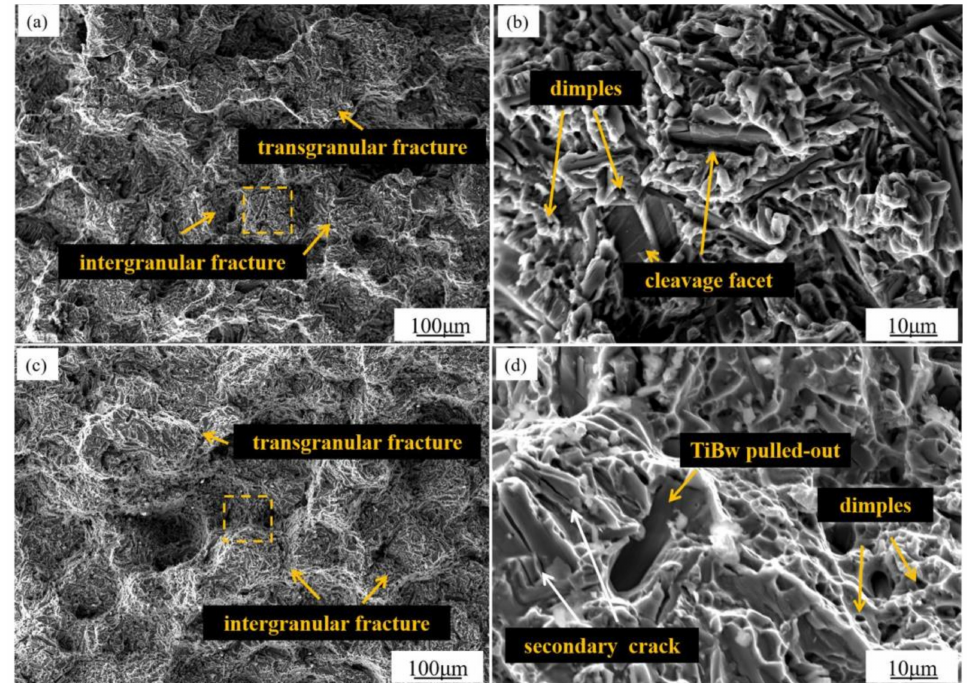
Figure 3. Fracture surface of TiB w /Ti-6Al-4V brazing joints brazed in 940 ◦ C for 2 h ( a , b ) room-temperature; ( c , d ) 400 ◦